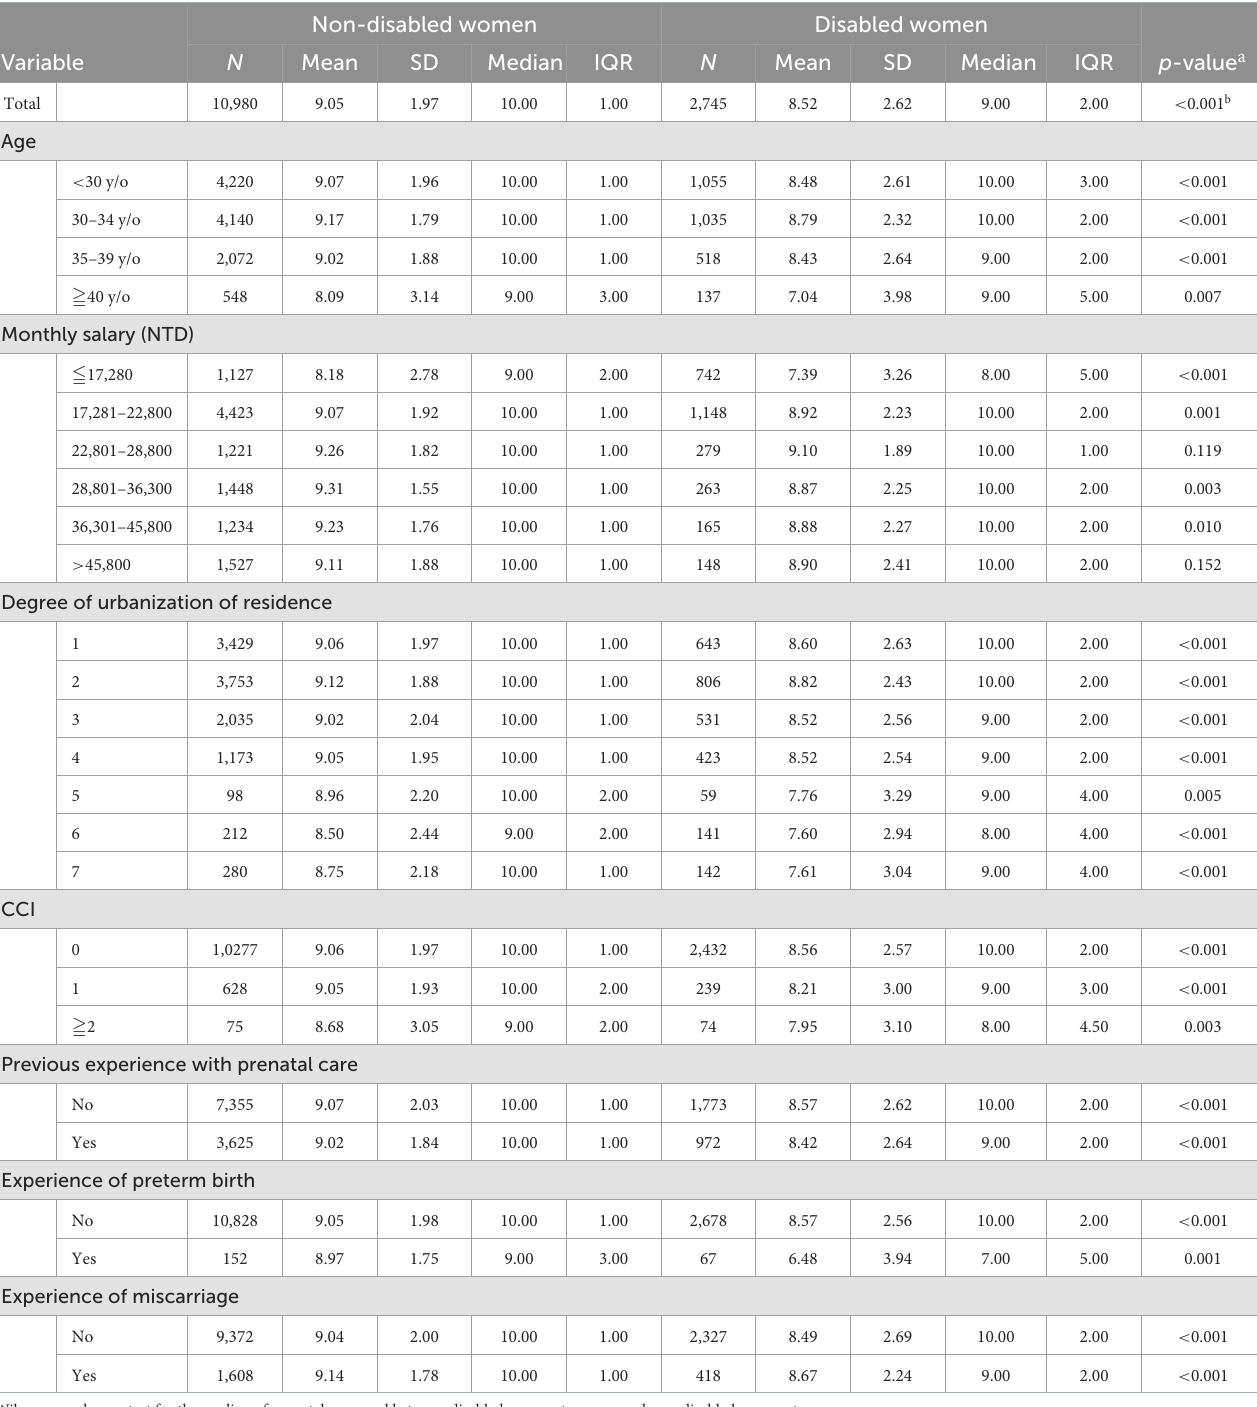
TABLE 2 Comparison of the utilization of prenatal care services between disabled pregnant women and non-disabled pregnant women (excluding those with preterm births). Non-disabled women Disabled